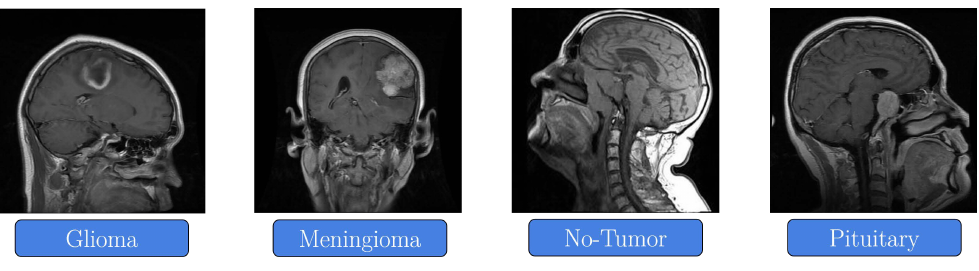
Figure 7. Sample of the MRIs in the